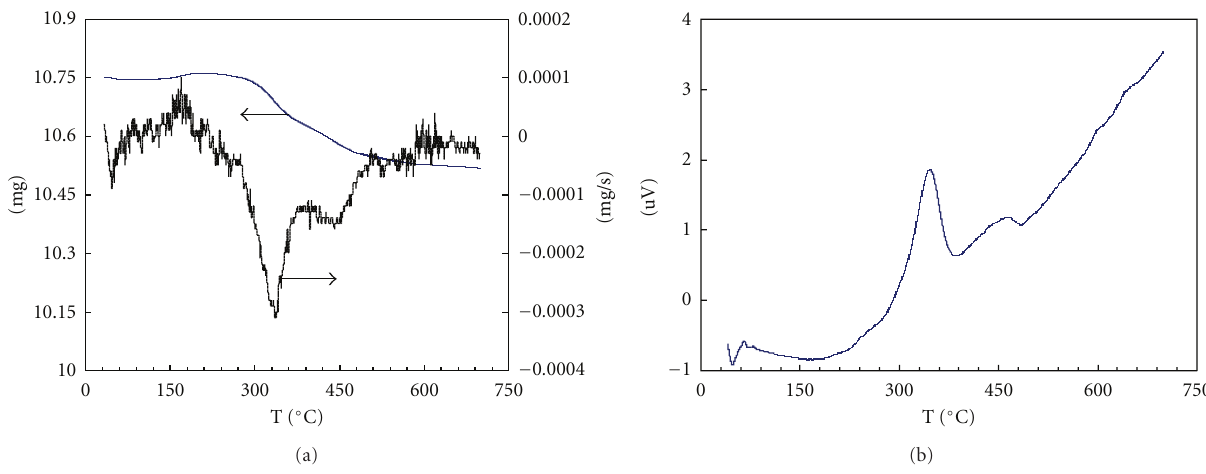
Figure 7: TG (a) and DTA (b) of the nitrogen-doped TiO 2